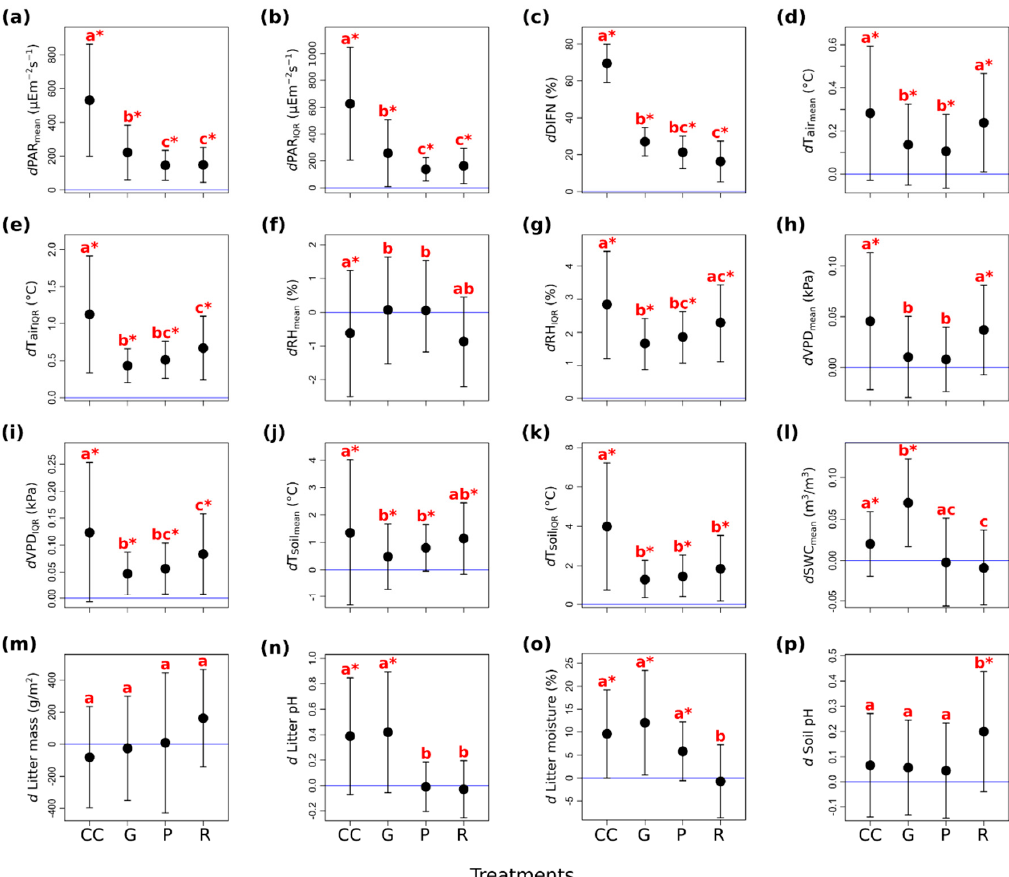
Figure 2. Changes in means and interquartile ranges (IQR) of the relative values of the site condition variables among the forestry treatments in Pilis Mountains, Hungary, 2015. ( a ) Mean and ( b ) IQR of photosynthetically active radiation (PAR; μ E m − 2 s − 1 ); ( c ) mean of relative diffuse light (DIFN; %); ( d ) mean and ( e ) IQR of air temperature (T air ; °C); ( f ) mean and ( g ) IQR of relative humidity (RH; %); ( h ) mean and ( i ) IQR of vapor pressure deficit (VPD; kPa); ( j ) mean and ( k ) IQR of soil temperature (T soil ; °C); ( l ) mean of soil moisture (SWC; m 3 /m 3 ); ( m ) total mass of collected litter on the surface (g/m 2 ); ( n ) litter pH (pH in water); ( o ) gravimetric moisture content of litter samples (%); ( p ) soil pH (pH in water). The letter ‘ d ’ in the variable abbreviations refers to the differences from the mean values measured in the control plots. The treatment types are coded as follows: CC—clear-cutting; G—gap-cutting; P—preparation cutting; R—retention tree group. Full circles show the mean and vertical lines denote the standard deviation of the samples. Letters designate the significant differences among the treatments (all of the pairwise multiple comparisons based on the linear mixed effects models; Tukey-test, alpha = 0.05), while asterisks denote significant differences from the values measured at the control plots (linear mixed effects models without intercept, p < 0.05). The horizontal blue line shows the level of the control.